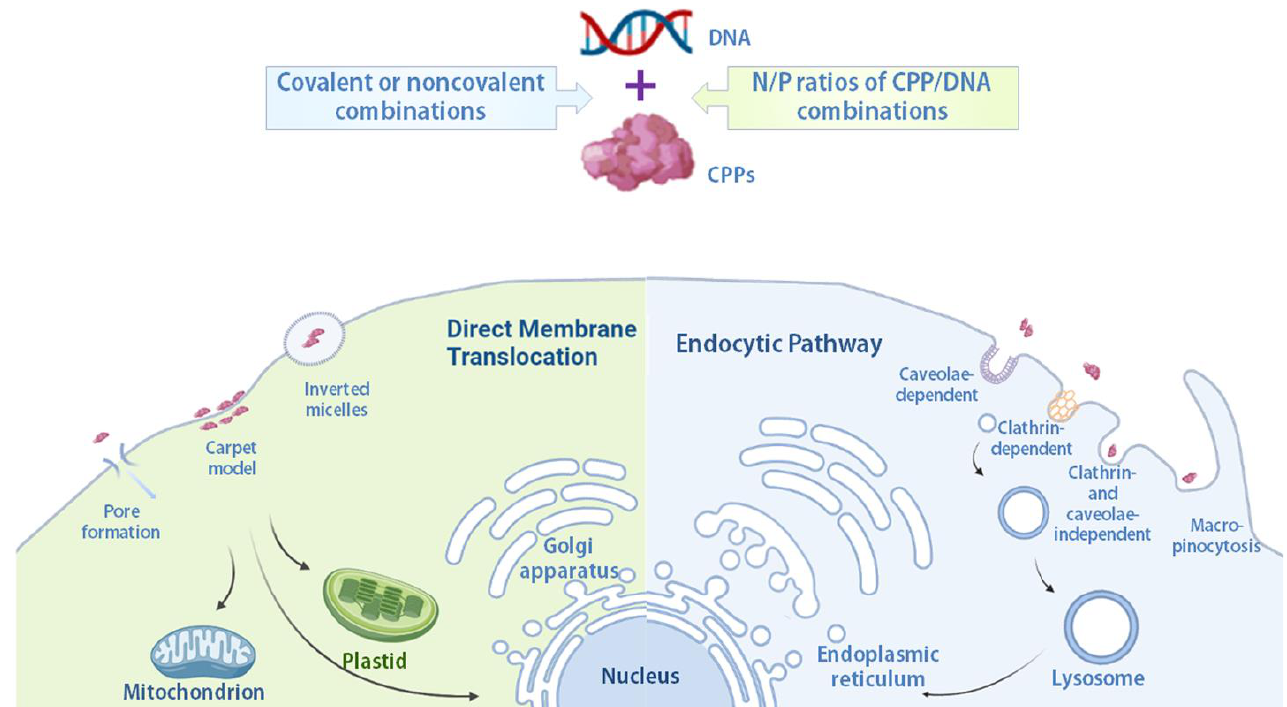
Figure 2. Cellular internalization mechanisms of CPP/DNA complexes and their subcellular targets in plant cells. There are two main routes of cellular internalization: endocytosis and direct membrane translocation. The internalized CPP/DNA complexes stay in the nucleus, plastids, or mitochondria, depending on signal sequences on CPPs. With endocytic pathway, CPP/DNA complexes have to escape from lysosomes eventually.